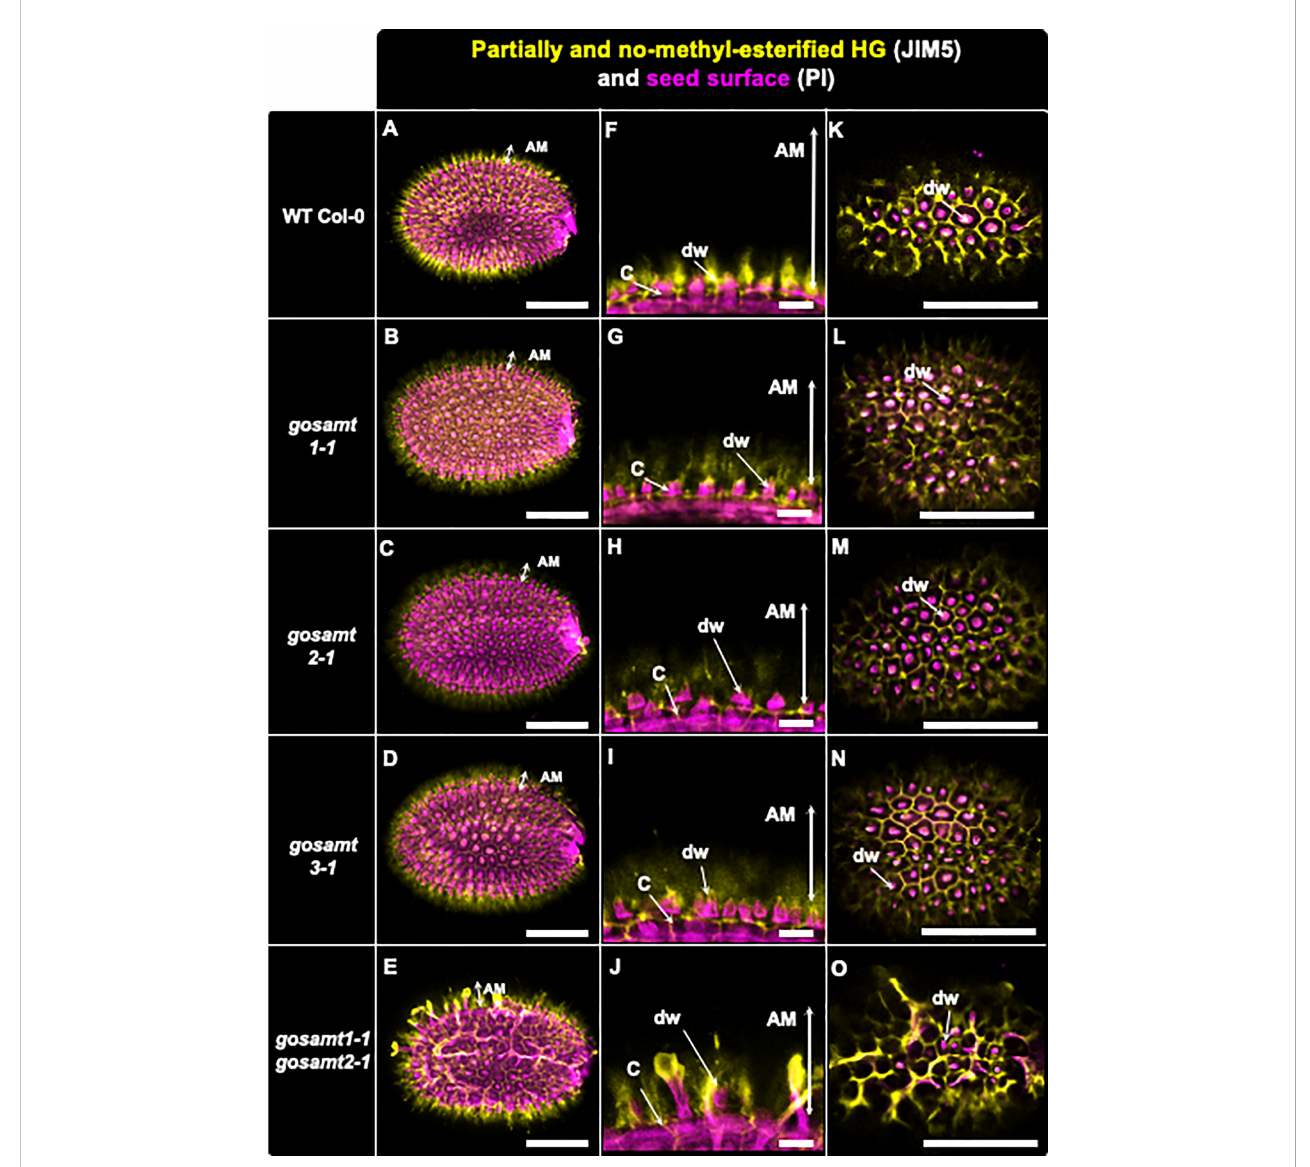
FIGURE 6 Distribution of low methyl-esteri fi ed homogalacturonans recognized by JIM5 antibody in adherent mucilage layers of wild-type and gosamts mutants. Confocal microscopy images of AM released from WT Col-0 and gosamts mutants mature imbibed seeds. Fluorescence corresponds to JIM5 antibody labelling in yellow, and propidium iodide used to detect seed surfaces in magenta. (A – D) Different optical planes showing entire seed. (F – J) Close-up of columella. (K – O) Top view of seed surface. C = columella; dw distal cell wall; vertical arrows in (F – J) indicate labelled AM. Scale bars: (A – E) and (K – O) =200 µm; (F – J) = 50